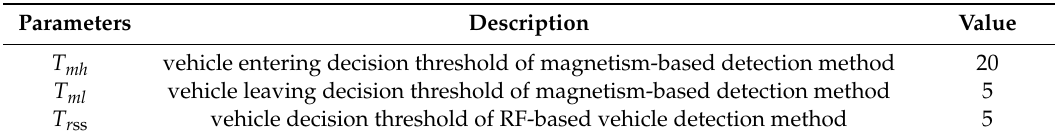
Table 1. Three thresholds used in our proposed